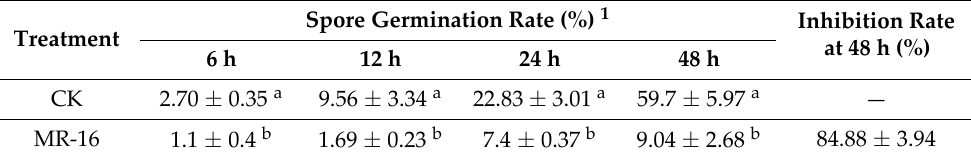
Table 3. Effects of culture filtrate of MR‑16 on the spore germination of F. oxysporum .